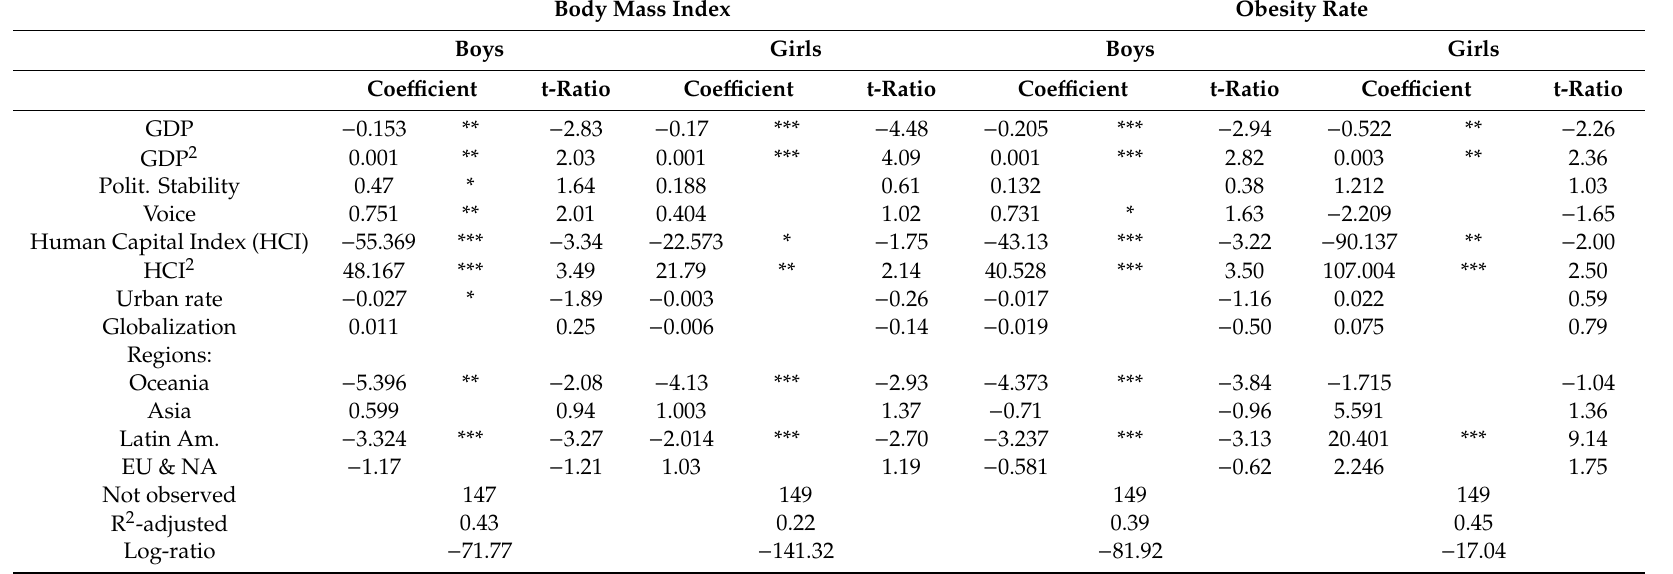
Table 4. Estimation (Ordered